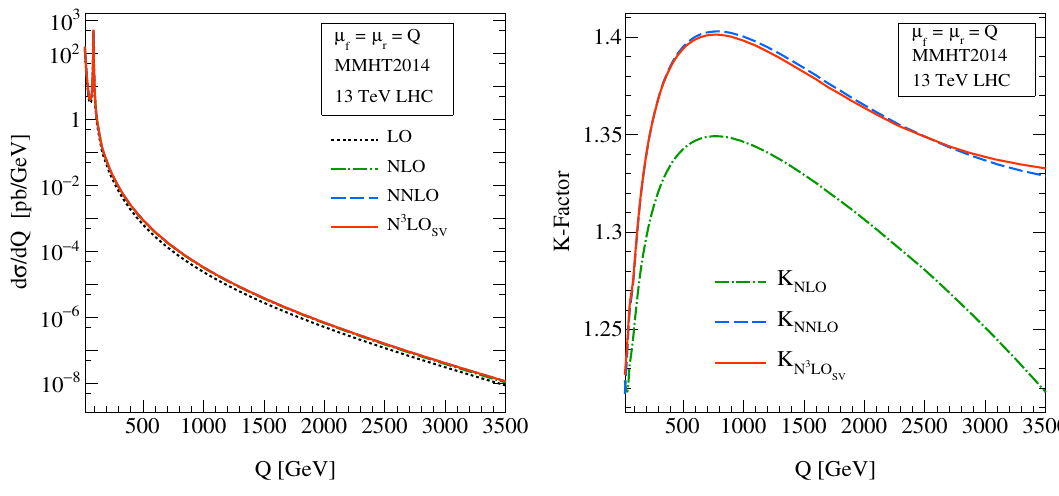
Figure 1 . The di-lepton invariant mass distribution (left panel) and the corresponding K -factors (right panel) are presented to N 3 LO sv in QCD for 13 TeV